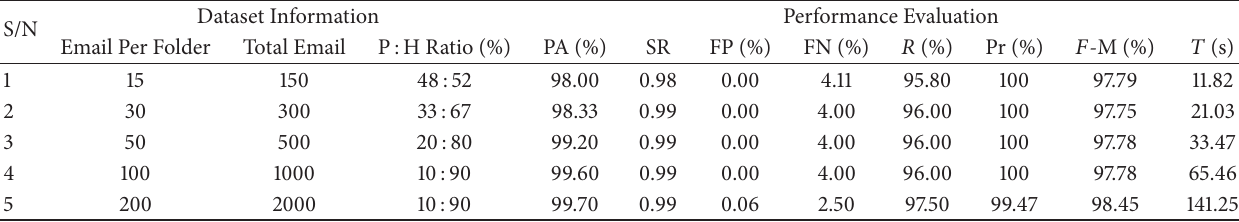
Table 2: 10-Fold cross validation Result.